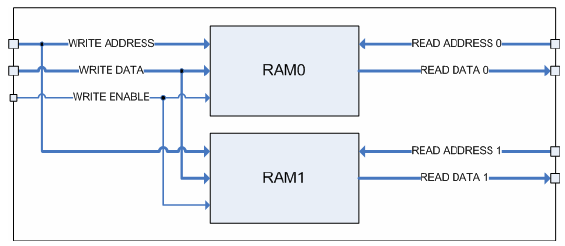
Figure 9. One write and two read ports RF. Result